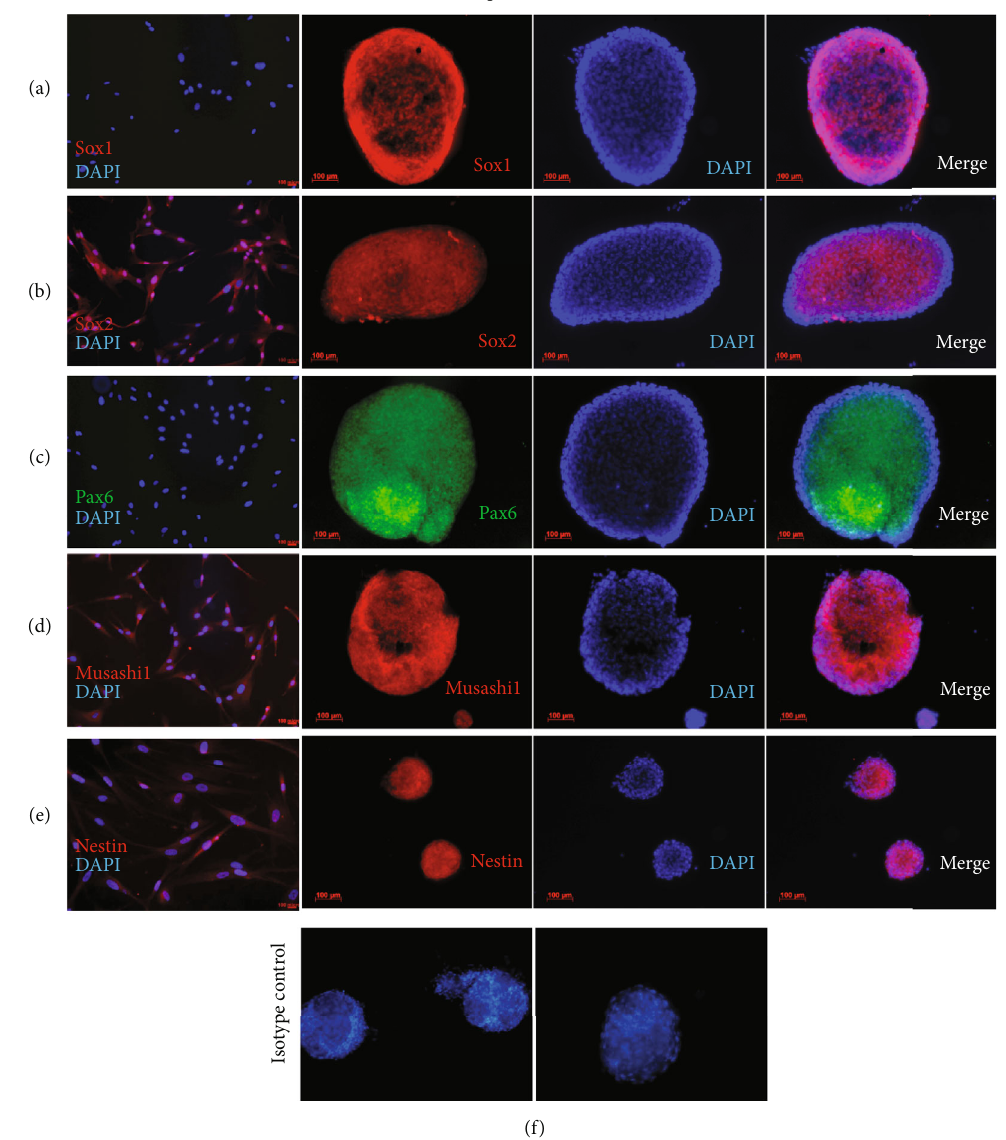
Figure 5: Protein expression pro fi le of WJ-MSCs and primed neuroectodermal cells. Panels “ A, B, C, D, and E ” show the immuno fl uorescence images of WJ-MSCs and WJ-MSCs primed neuroectodermal cells stained with respective antibody. Panel “ F ” shows IgG control for anti-mouse (left) and anti-rabbit (right) antibodies ( mean ± SEM , n = 3